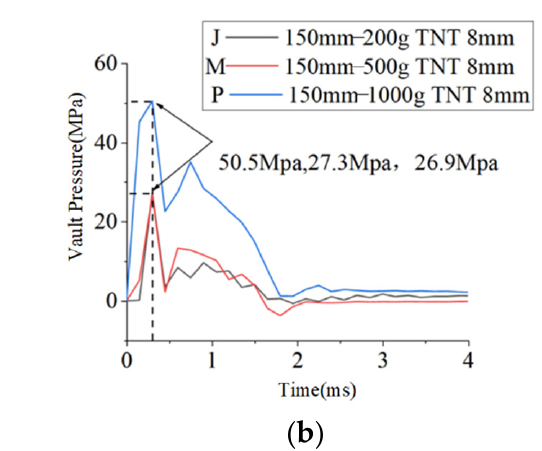
Figure 9. Pressure on the arch vault under a standoff distance of 0.4 m and an amount of TNT of 0.5 kg.